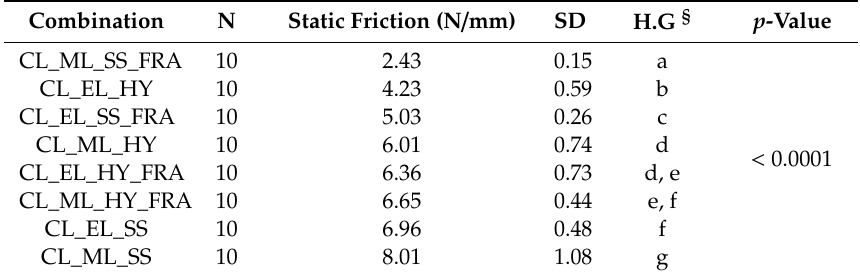
Table 2. Static friction values in metallic conventional ligation brackets (CL). The letters show significance statistical di ff erences.